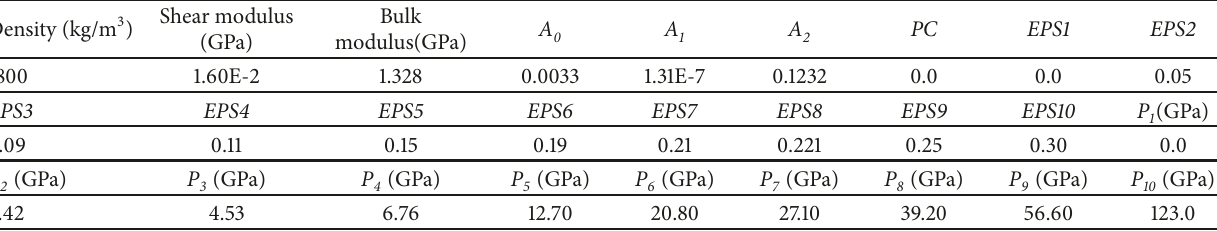
Figure 11: Numerical simulation models. Table 8: Parameters of the stemming material.